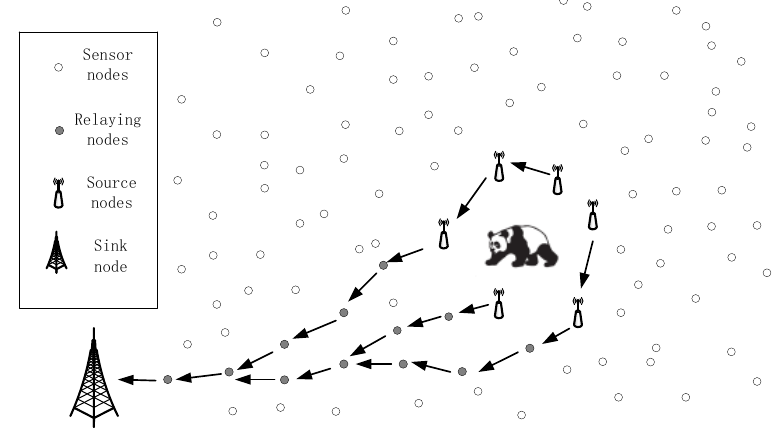
Figure 1. A scenario of target monitoring.